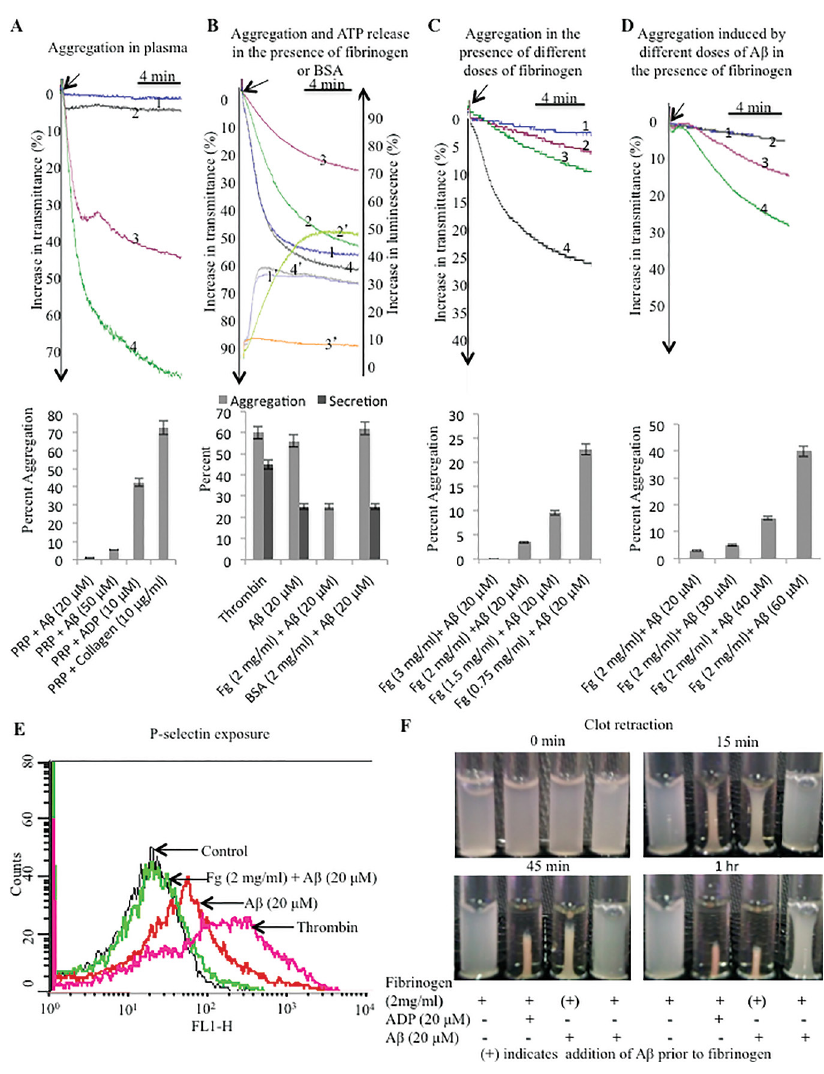
-induced platelet activation. (A) Tracings 1, 2, 3 Figure 1. Effect of fibrinogen on A β 25–35 and 4 represent platelet aggregation in PRP induced by A β (20 and 50 μ mol/L), ADP 25–35 (20 μ mol/L) and collagen (10 μ g/mL), respectively. The corresponding bar diagram is shown in the lower panel. (B) Tracings 1–4 represent aggregation, and tracings 1’–4’ represent corresponding dense granule secretion in washed platelets stimulated with either thrombin (1 U/mL; tracings 2 and 2’) or A β (20 μ mol/L; tracings 1, 1 ′ , 3, 3 ′ , 4 and 4 ′ ). 25–35 Tracings 3 and 3 ′ represent platelets pretreated with fibrinogen (2 mg/mL), whereas tracings 4 and 4’ represent platelets pretreated with BSA (2 mg/mL). Corresponding bar diagram is shown in the lower panel. (C) Tracings 1, 2, 3 and 4 represent aggregation of washed platelets induced by A β (20 μ mol/L) in the presence of 3, 2, 1.5 and 0.75 mg/mL 25–35 fibrinogen, respectively. Corresponding bar diagram is shown in the lower panel. (D) Trac- ings 1, 2, 3 and 4 represent aggregation of washed platelets induced by A β (20, 30, 40 25–35 and 60 μ mol/L, respectively) in the presence of fibrinogen (2 mg/mL). Corresponding bar diagram is shown in the lower panel. (E) Flow cytometric analysis of expression of P-selectin on surface of platelets treated with different reagents and agonists as indi- cated. (F) Retraction of fibrin clot by platelets stimulated with either A β (20 μ mol/L) or 25–35 ADP (20 μ mol/L) in presence of fibrinogen (2 mg/mL) added either before or after exposure to agonists as